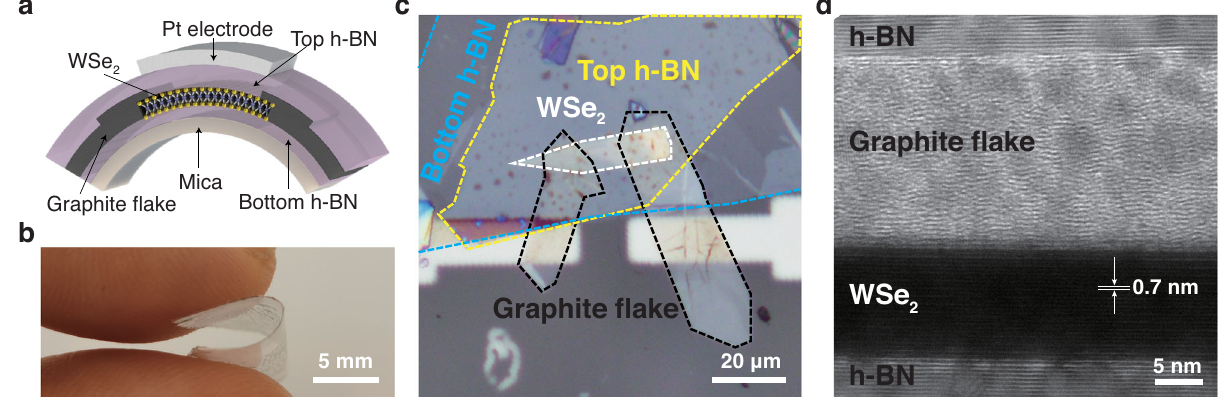
Fig. 1 | High-temperature-resistant fl exible WSe 2 photodetector. a Schematic view of WSe 2 photodetector with h-BN encapsulation and GF (graphite fl ake) electrodes on mica substrate. b Optical image of the WSe 2 device on fl exible mica substrate. c Optical microscopy image of the WSe 2 device which is consist of 5